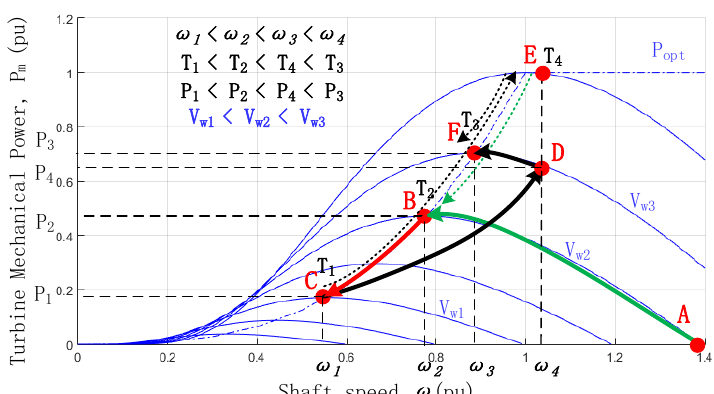
Figure 7. Maximum power point tracking (MPPT) control strategy.